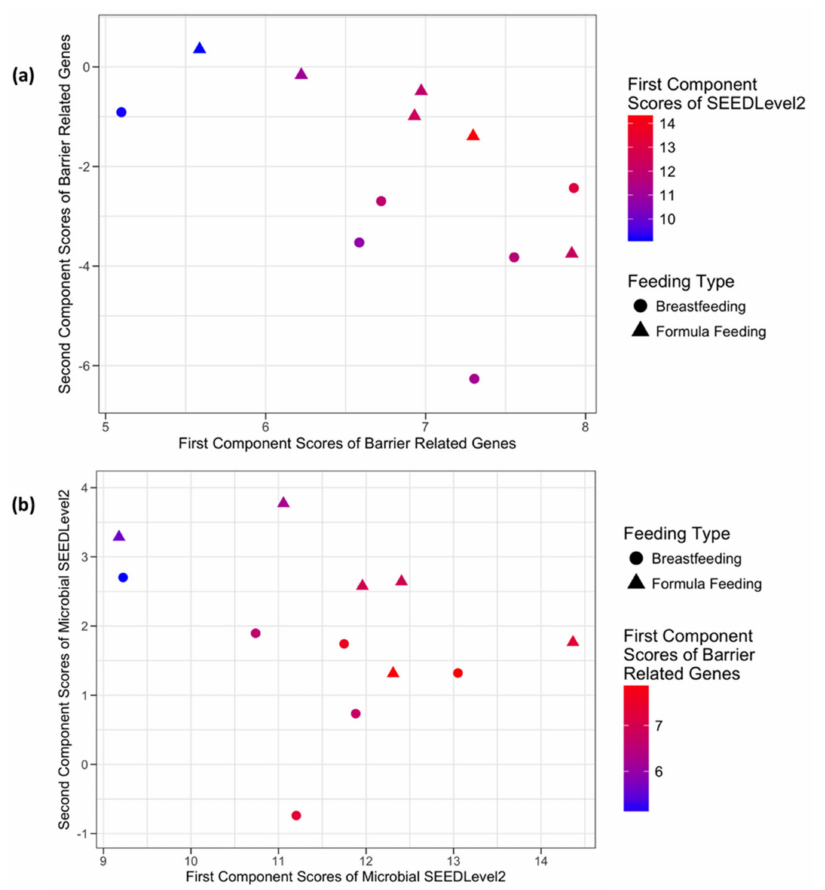
Figure 6. sCCA plots for barrier related host genes and the microbial communities at SEEDLevel2. In panel ( a ), the x-axis and the y-axis represent the first and the second component scores from the normalized microarray expression of the barrier related host genes, respectively. The list of genes forming these two components is described in Table S9a. Coloring of the sample points represents the first component scores from the microbial communities from the SEEDLevel2 subsystem. In panel ( b ), the x-axis and the y-axis represent the first and the second component scores from the normalized SEEDLevel2 subsystem of microbial communities, respectively. The list of genes forming these two components is described in Table S9a. Coloring of the sample points represents the first component scores from the normalized microarray expression of the barrier related host